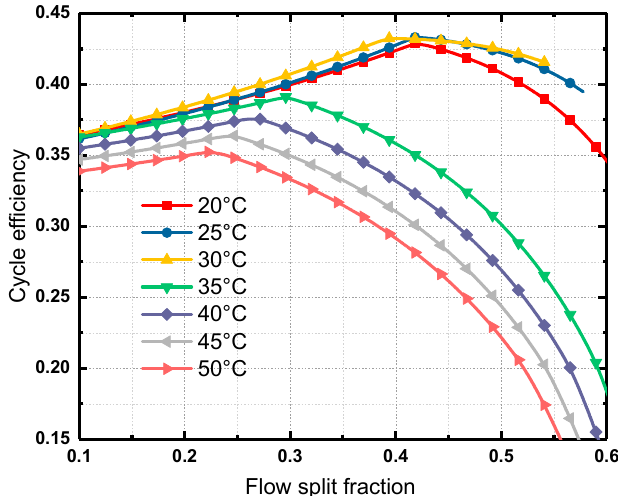
Figure 7. Cycle efficiency versus split fraction during the transition from supercritical to liquid phase at supercritical pressure at different compressor inlet temperatures.